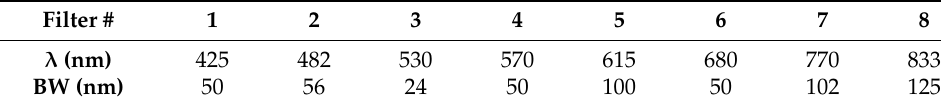
Figure 1. ( Left ) Normalized spectral sensitivity of the sensor. ( Right ) Spectral transmittance of the 8 selected filters. Table 1. Central wavelengths and bandwidths of the selected filters.